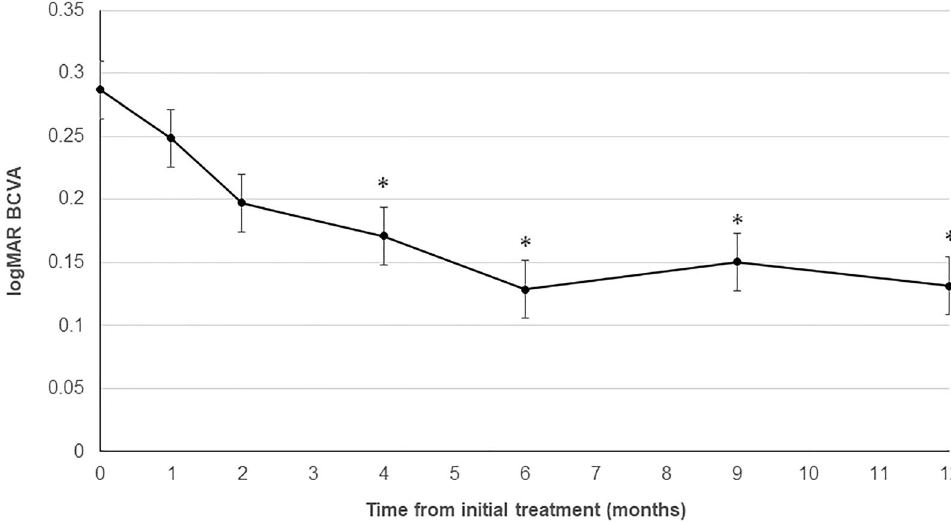
Figure 1. Changes in the best-corrected visual acuity (BCVA) during the 12-month follow-up period. The mean BCVAs at 4, 6, and 12 months improved significantly compared with the preoperative VA (* P < 0.05).